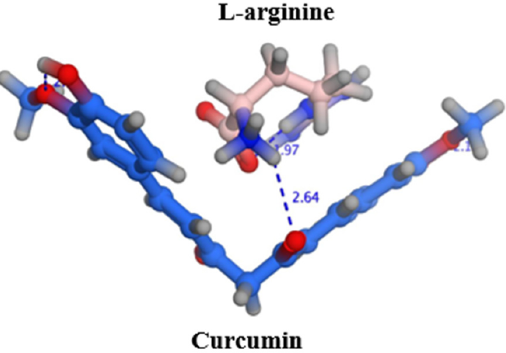
Figure 1. Possible interactions between curcumin and L-arginine. Dashed lines denote H-bond length in Angstrom.